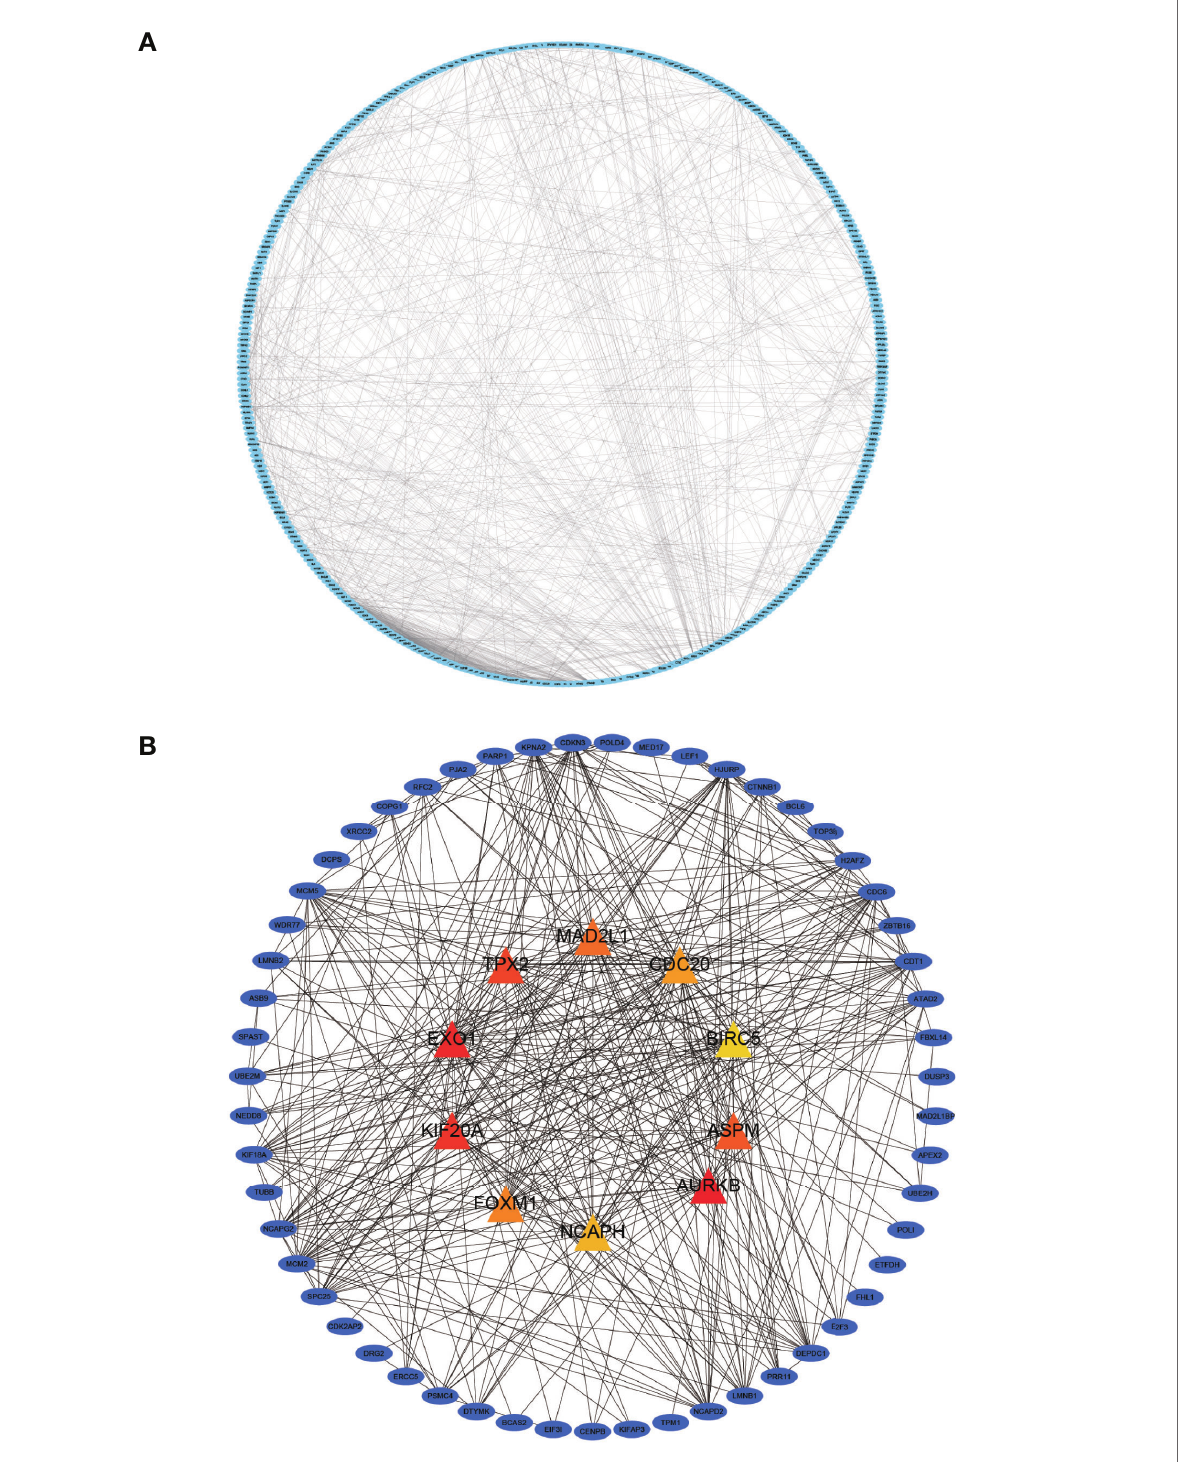
FIGURE 7 | Protein-protein interaction (PPI) network diagram of DEGs and visualization of the Hub gene. (A) shows the PPI network diagram derived from the STRING input library; (B) shows the Hub gene identi fi ed by